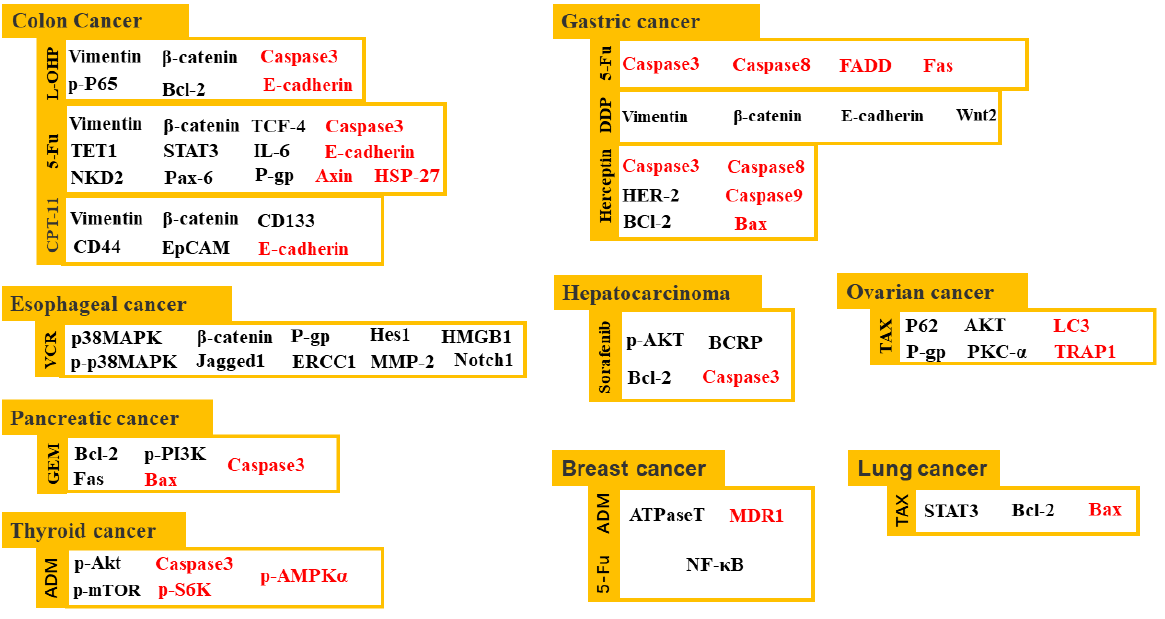
Figure 3. Curcumin reverses chemotherapeutic resistance of multiple cancer cell lines through regulation of multiple gene expression. The black words represent the targets downregulated by curcumin, whereas the red words denote the targets upregulated by curcumin. (L-OHP, oxaliplatin; 5-Fu, 5-fluorouracil; CPT-11, irinotecan; VCR, vincristine; GEM, gemcitabine; ADM, doxorubicin; DDP, cisplatin; and TAX, paclitaxel).